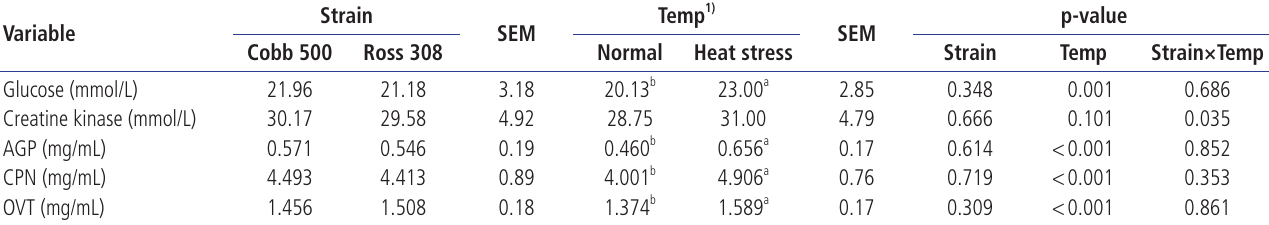
Table 3. Effects of strain and temperature on serum concentrations of glucose, creatine kinase, α 1-acid glycoprotein, ceruloplasmin, and ovotransferrin in broiler chickens at 35 days of age Strain Variable